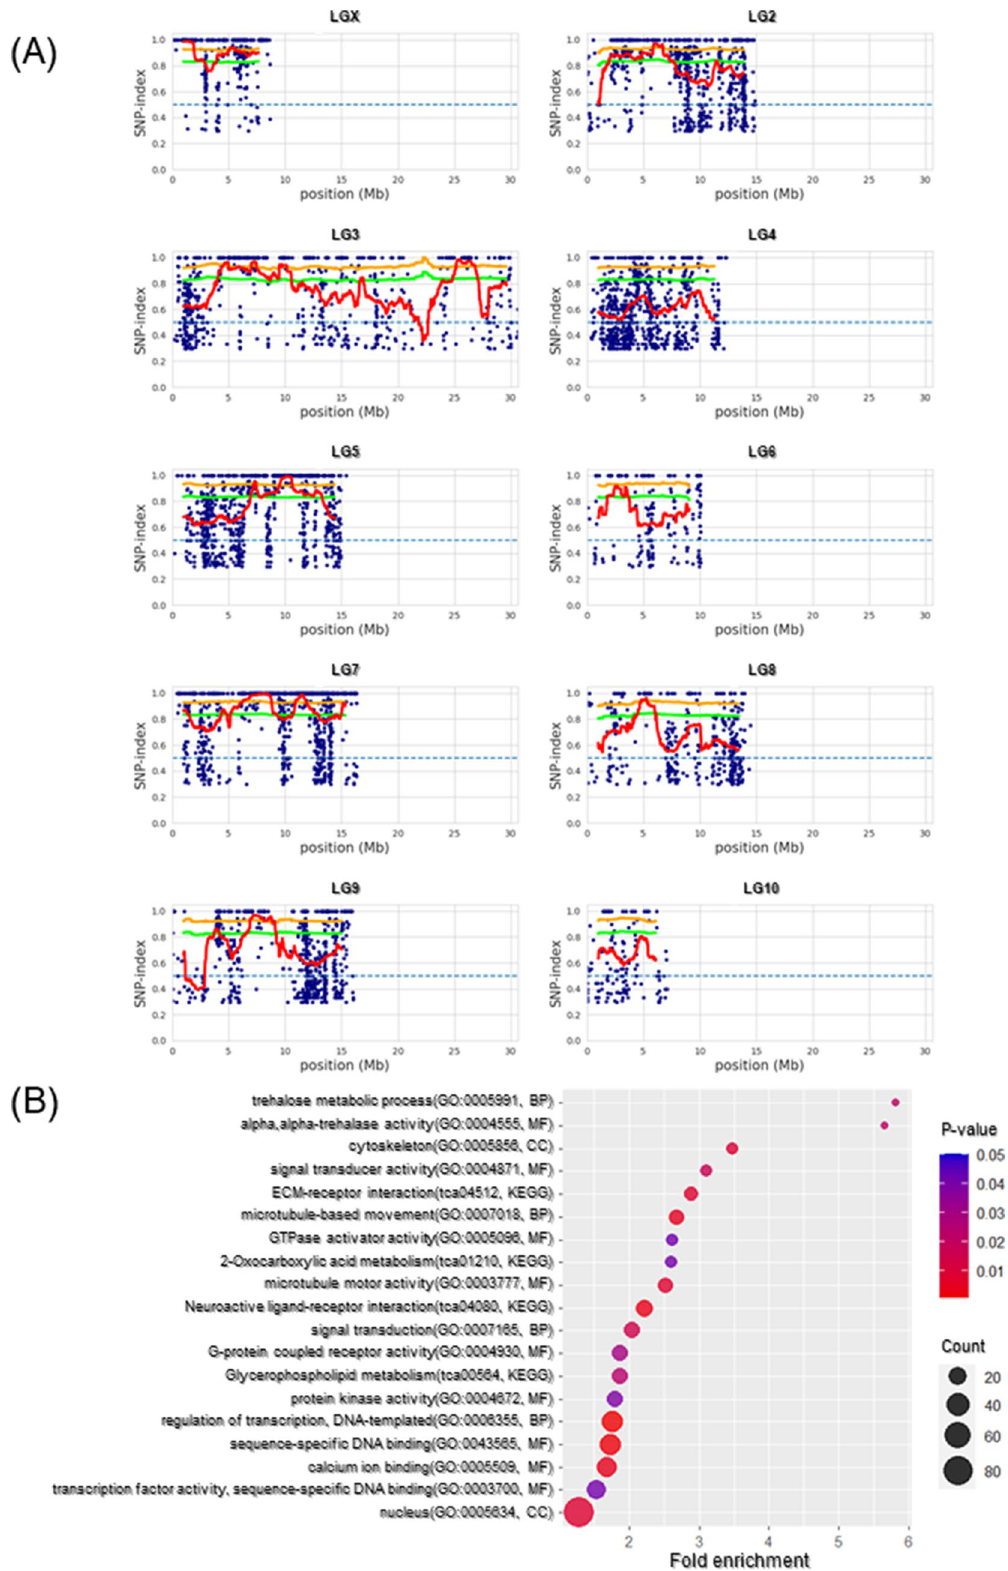
Figure 3. Analytical results of MutMap approach in each linkage group ( A ) and enrichment analysis ( B ). In ( A ), the red line indicates an approximate line of plot data. The green and orange threshold lines indicate 95% and 99% significance, respectively. The dot plot in ( B ) is generated using the R package “ggplot” (version 3.3.5, https:// cran.r- proje ct. org/ web/ packa ges/ ggplo t2/ index.